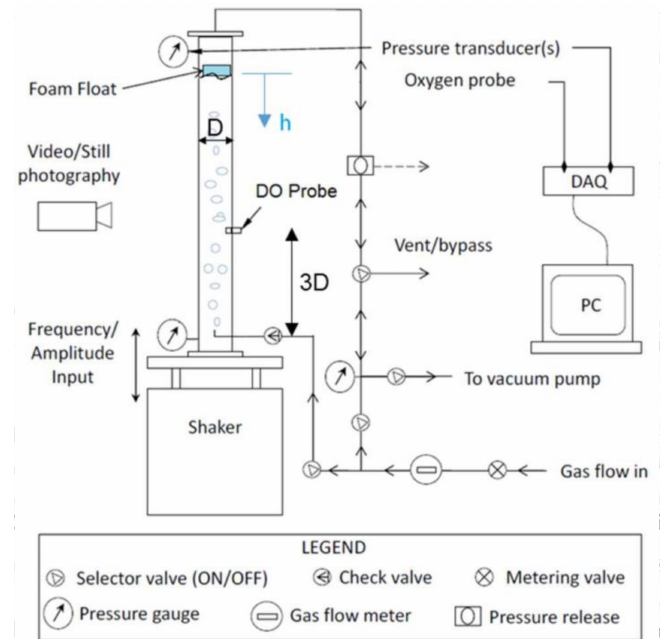
Figure 1. Schematic of the experimental setup including the bubble column mounted on the shaker table and the